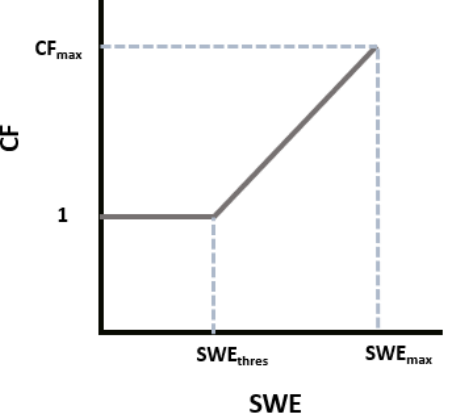
Figure 2. Schematic of linear relationship between SWE and correction factors.